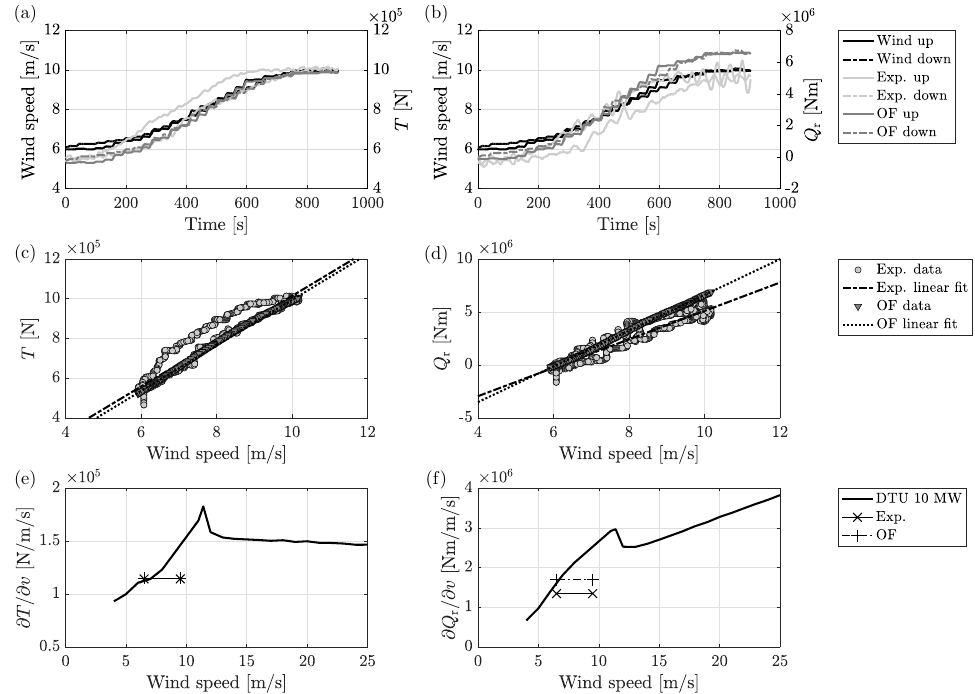
Figure 9. The aerodynamic response to a wind speed ramp for the wind turbine model is compared at full-scale to the OpenFAST (OF) model of the scaled model; the corresponding thrust and torque sensitivities to wind speed are compared to the DTU 10 MW. ( a , b ) Thrust and torque response to a wind speed ramp for the scale model turbine. ( c , d ) Linear fit of the thrust and torque response to wind speed. ( e , f ) Thrust and torque sensitivities to wind